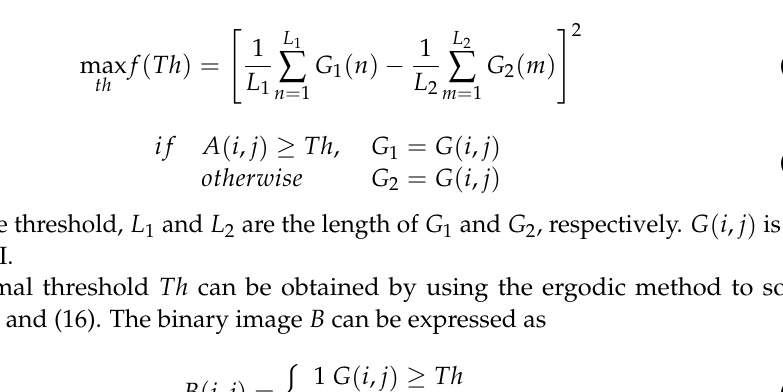
Figure 5. TFDIs of the raw signal at −6 dB and reconstructed signals based on ASVR and the method in [19].